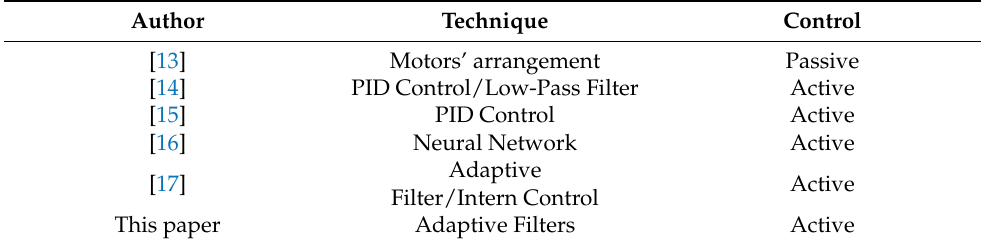
Table 1. Comparative table of publications on the subject in the last 7